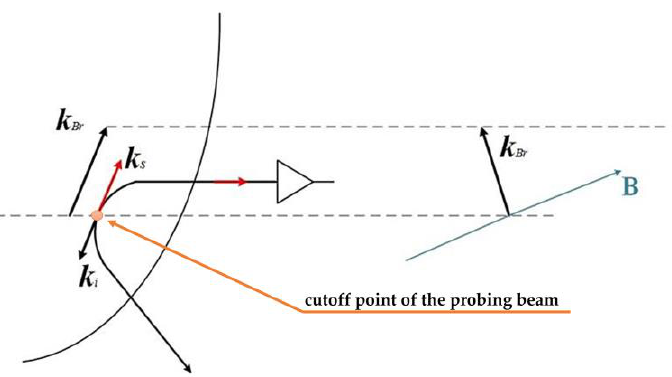
Figure 3. Schematic of a microwave beam incident on the reflection layer with fluctuations.